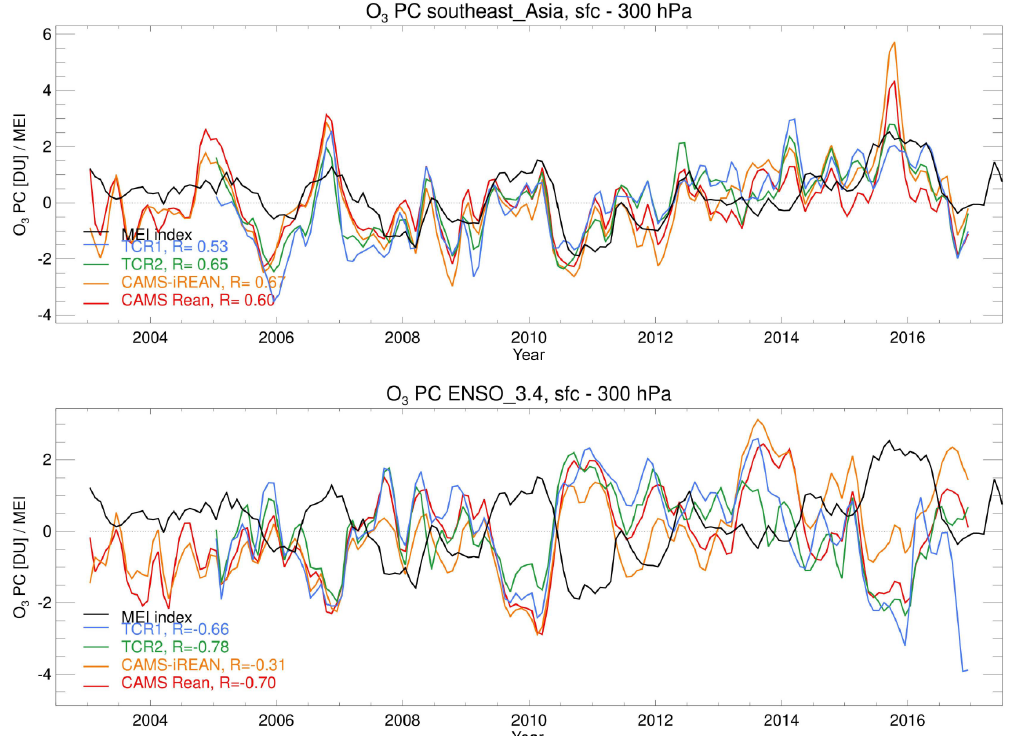
Figure 16. De-seasonalized anomalies in O 3 partial columns (surface to 300hPa) in the four reanalyses, as compared to the MEI for two regions: Southeast Asia (10 ◦ S–20 ◦ N, 90–120 ◦ E) and ENSO3.4 over the eastern Pacific ( 5 ◦ S–5 ◦ N, 120–170 ◦ W). A 2-month smoothing has been applied to the reanalysis data (as for the MEI). Temporal correlations with respect to the MEI index are given in the legends. Correlations are calculated on monthly data for the 2005–2016 time